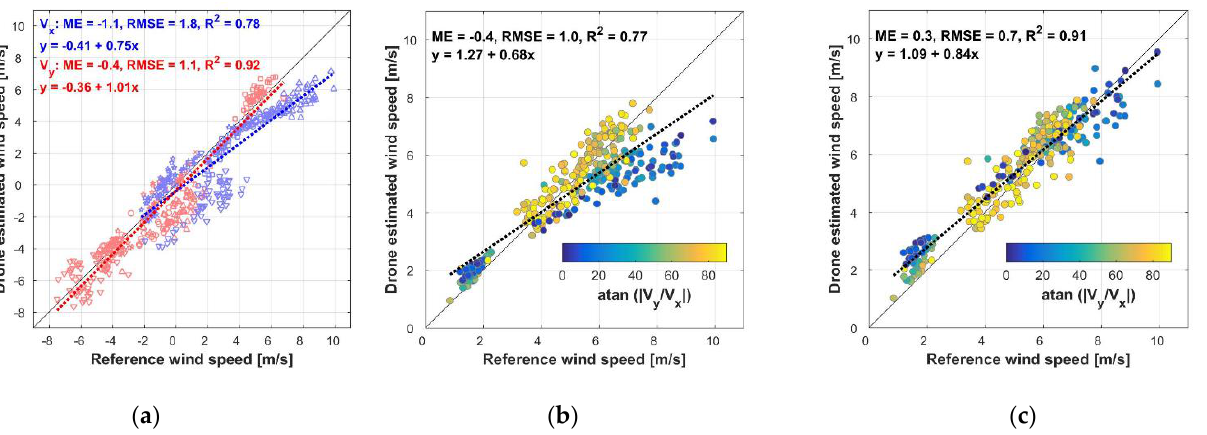
Figure 4. Comparison between 𝑣 𝑥 (red markers) and 𝑣 𝑦 (blue markers) components ( a ) and wind speed ( b ), averaged over 30-s intervals, according to the reference IRGASON measurements and the drone-based estimate before correction, and for the wind speed after applying the proposed correction for 𝑣 𝑥 component ( c ). 𝑣 𝑥 and 𝑣 𝑦 values are shown in ( a ) by blue and red color, respectively. Different symbols in ( a ) indicated to different hovering experiments.